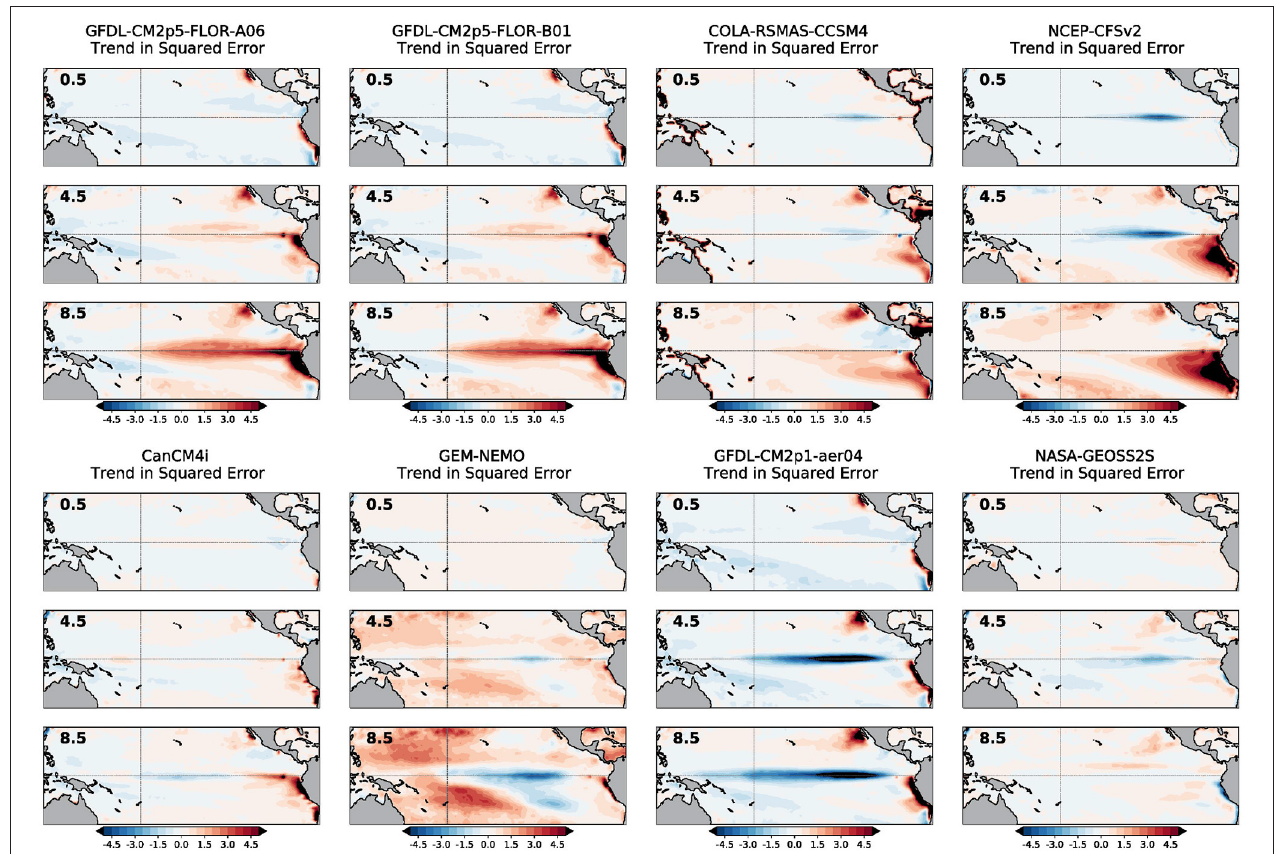
FIGURE 3 | As in Figure 2 except showing the linear trend in the squared error of monthly sea surface temperatures from January 1982 to December 2020. Units are in degrees Celsius squared.